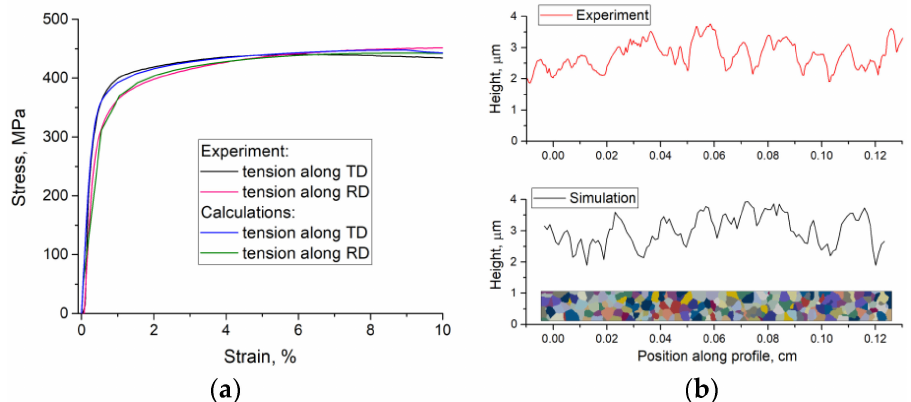
Figure 4. Stress-strain curves ( a ) and surface profiles at 5% tensile strain ( b ) obtained experimentally and